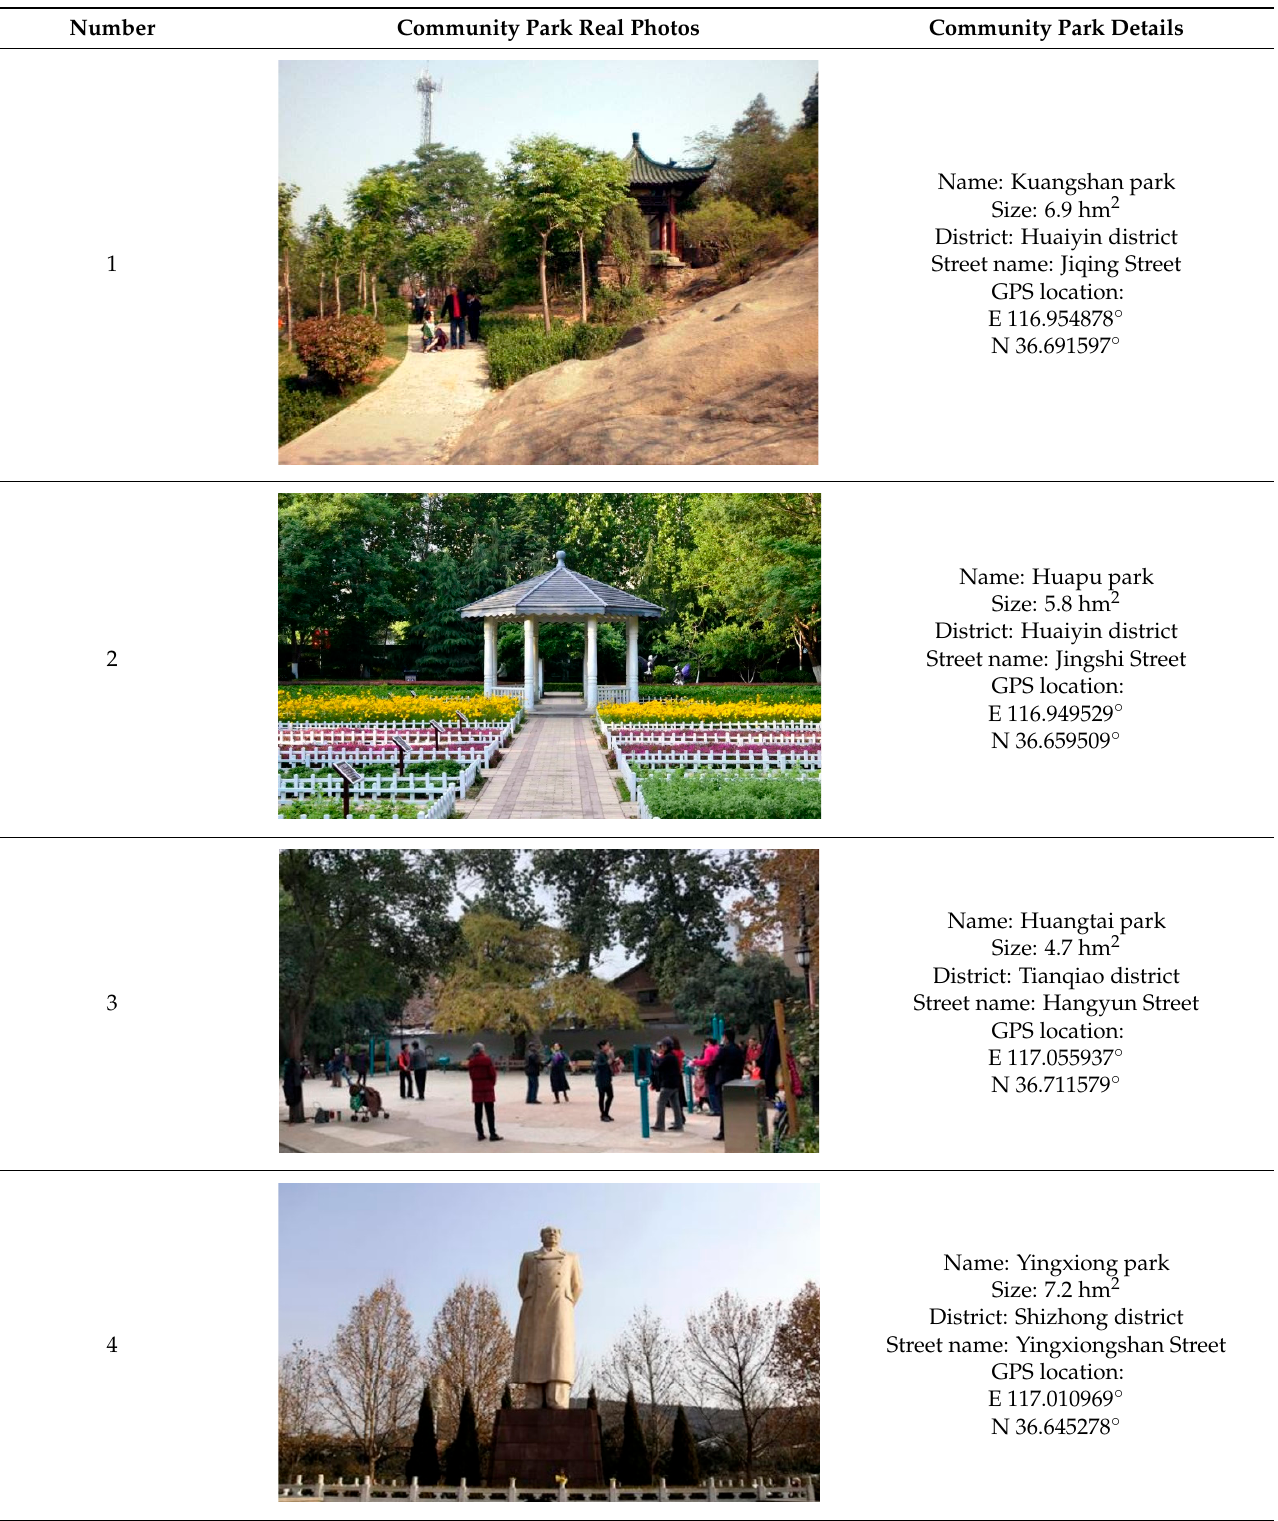
Table 1. The community parks in Jinan Table 1. The community parks in Jinan City. Table 1. The community parks in Jinan City. Table 1. The community parks in Jinan City. Table 1. The community parks in Jinan City.